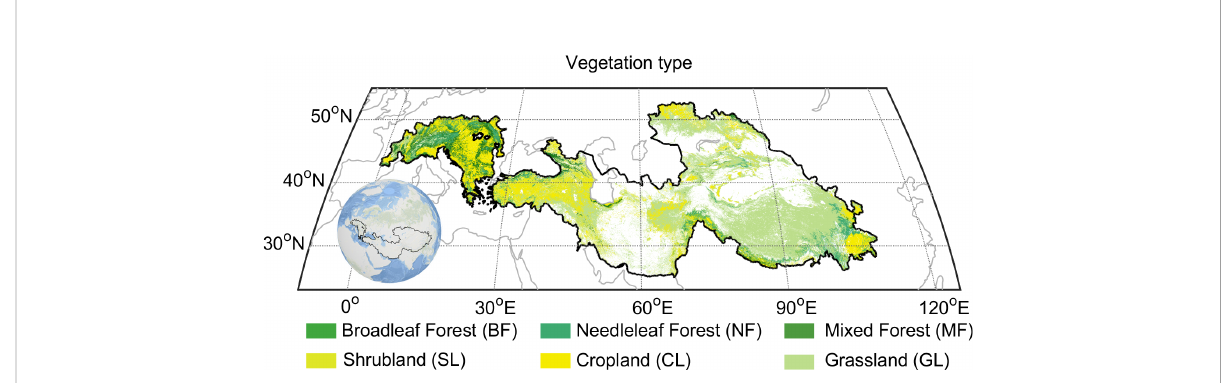
FIGURE 1 Distribution of vegetation type over the Pan-Third Pole. Vegetation type from the Global Land Cover 2000 (GLC2000) project uses the FAO Land Cover Classi fi cation